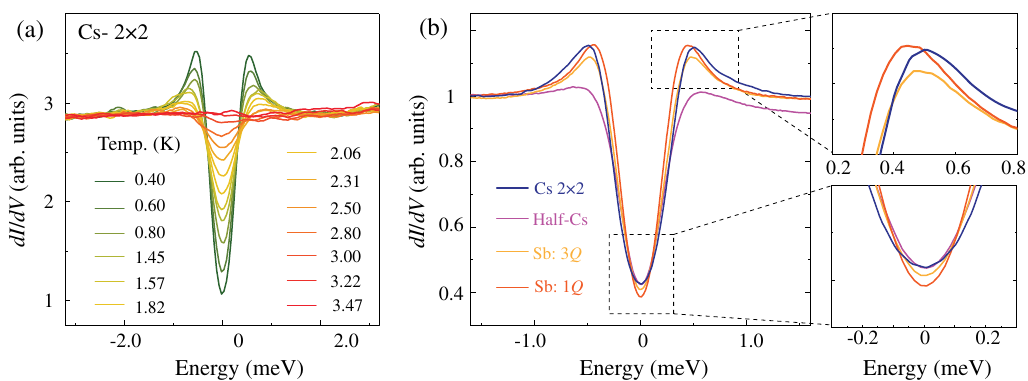
FIG. 3. (a) Temperature evolution of the superconducting gap. (b) Superconducting spectra obtained on different types of surfaces. The spectra of half-Cs, Sb 3 Q − 2 × 2 , and Sb 1 Q regions are obtained in one field of view with the same tip. STM setup condition: (a), (b) V S ¼ − 2 mV, I t ¼ 200 pA, V m ¼ 0 . 1 mV.